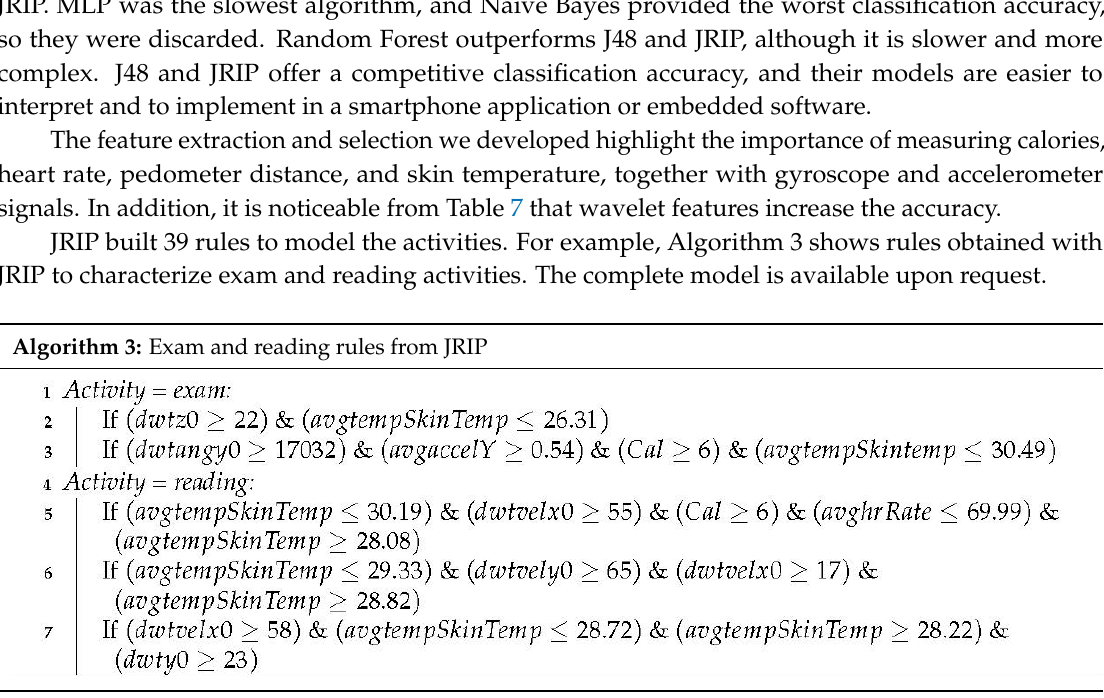
Sensors 2019 , 19 , x FOR PEER REVIEW